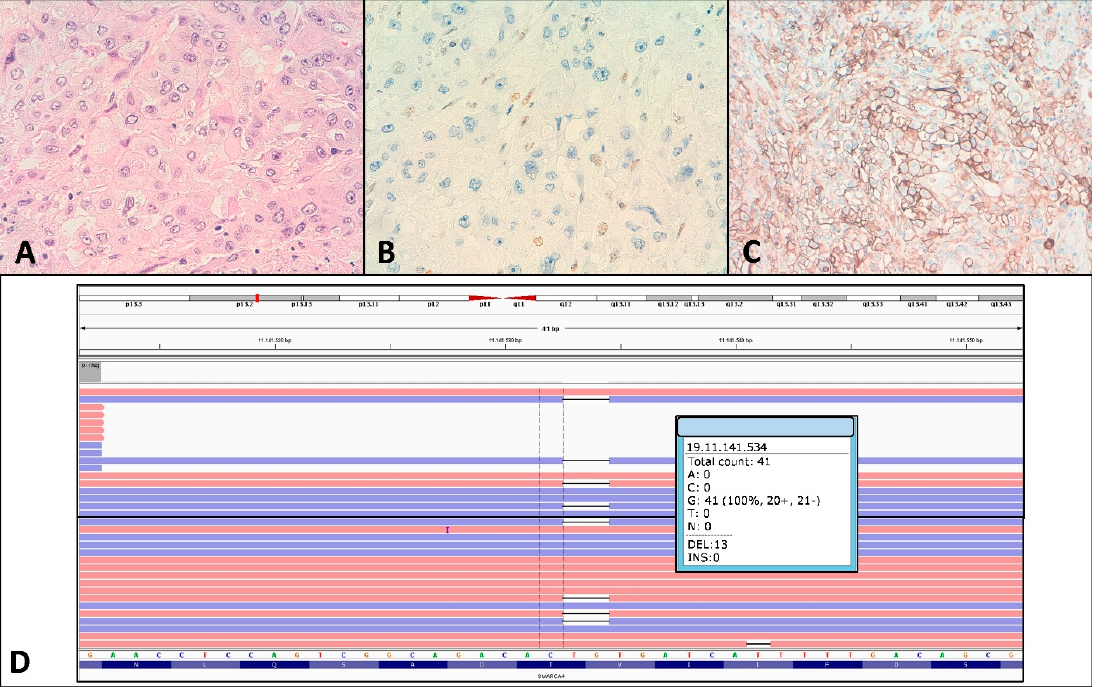
Figure 5. Tumor T19 mutated in SMARCA4 . ( A ) Hematoxylin-eosin showing a high-grade colorectal carcinoma. ( B ) SMARCA4 immunostaining showing a complete loss of expression. ( C ) PDL1 had a membranous positivity in more than 50% of epithelial cells. ( D ) IGV view of SMARCA4 c.3512_3513delTG (p.Val1171fs) mutation. C-MET was overexpressed in 16 tumors and it was significantly overexpressed in a higher proportion of MMRd tumors (55.2%) compared with MMRp tumors (9.1%) ( p =